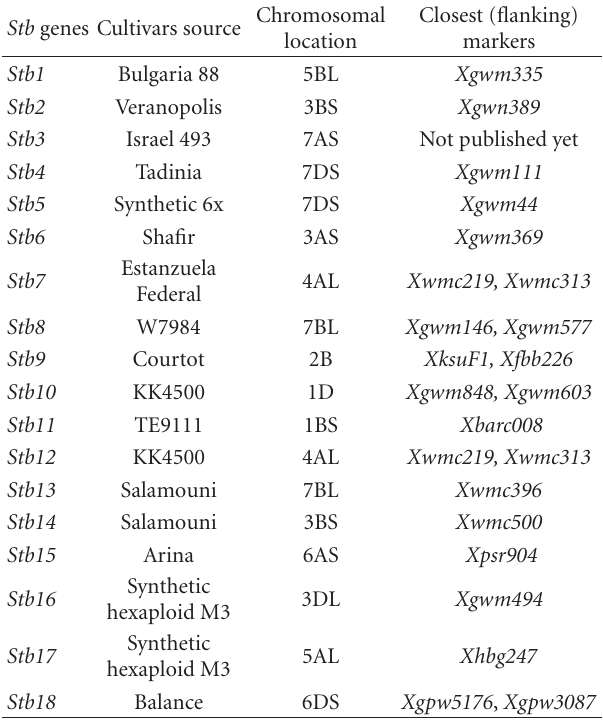
Table 1: Major genes conditioning resistance to Mycosphaerella graminicola identified in hexaploid